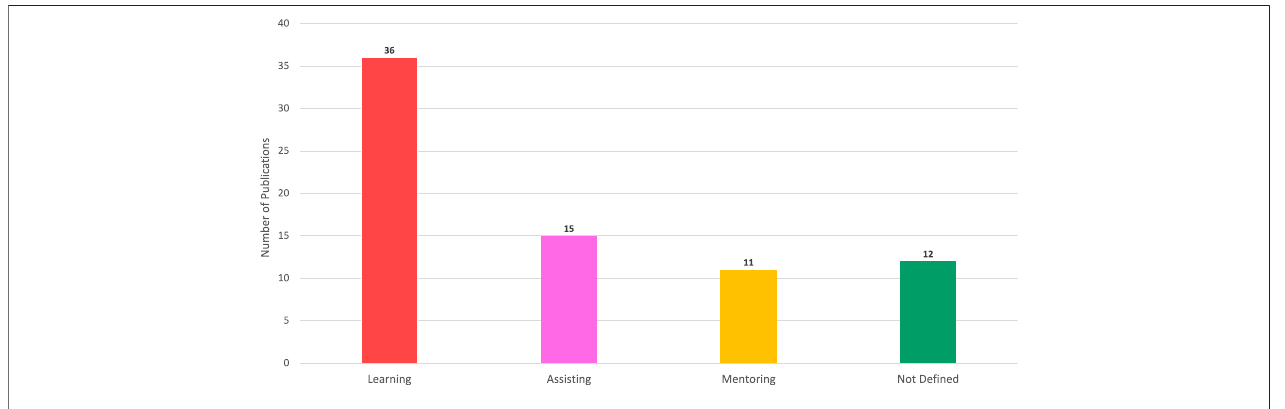
FIGURE 8 | Pedagogical roles identi fi ed in chatbot